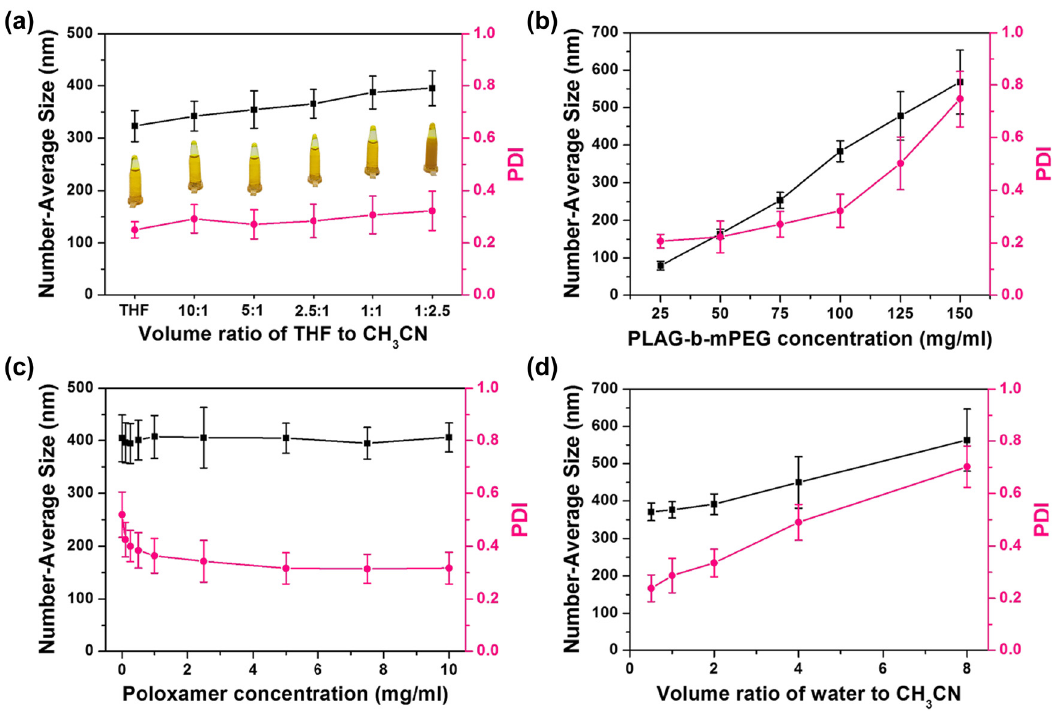
Figure 2: Optimization of the Em - MNPs. Hydrodynamic size of Em - MNPs prepared under di ff erent ( a ) volume ratios of THF to CH 3 CN, ( b ) PLAG - b - mPEG concentration, ( c ) poloxamer concentration, and ( d ) volume ration of water to CH 3 CN.